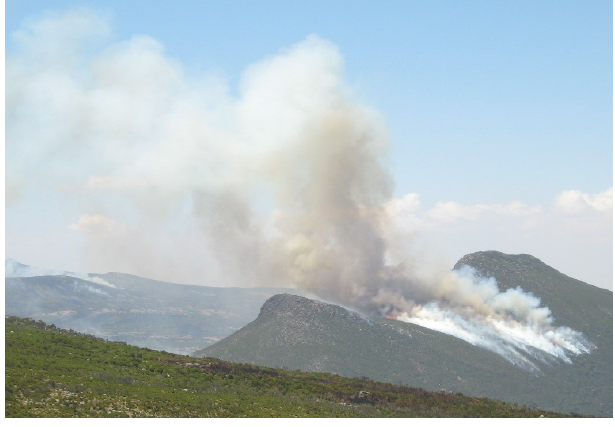
Fig. 3 . Heathland fires on February 4, 2008 at 1210 hours on a northeast-facing slope, ignited at multiple points along a straight line and allowed to burn uphill, supported both by the slope effect and the noon uphill wind. Note the other fires on the mountain in the background to the left.